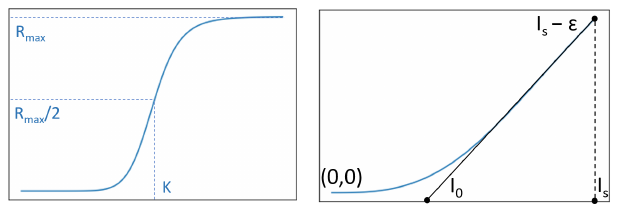
Figure 4. (Left): the Naka–Rushton function with parameters R max , K and n . (Right): the modulation function, shaped like the left-hand side of the Naka–Rushton function, showing parameters I s , I 0 and (cid:101)